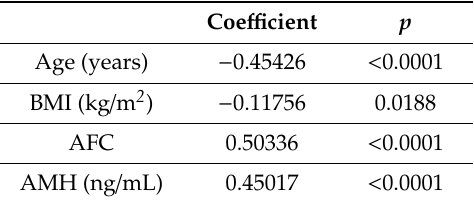
Table 1. Correlation among the Ovarian Sensitivity Index (OSI), clinical (age, BMI), endocrine anti-Mullerian hormone (AMH) and US antral follicle count (AFC) variables related to the ovarian responsiveness (univariate analysis). Age and BMI turned out to be negatively related to the OSI, whereas the AMH and AFC were positively related. All the correlations were statistically significant.